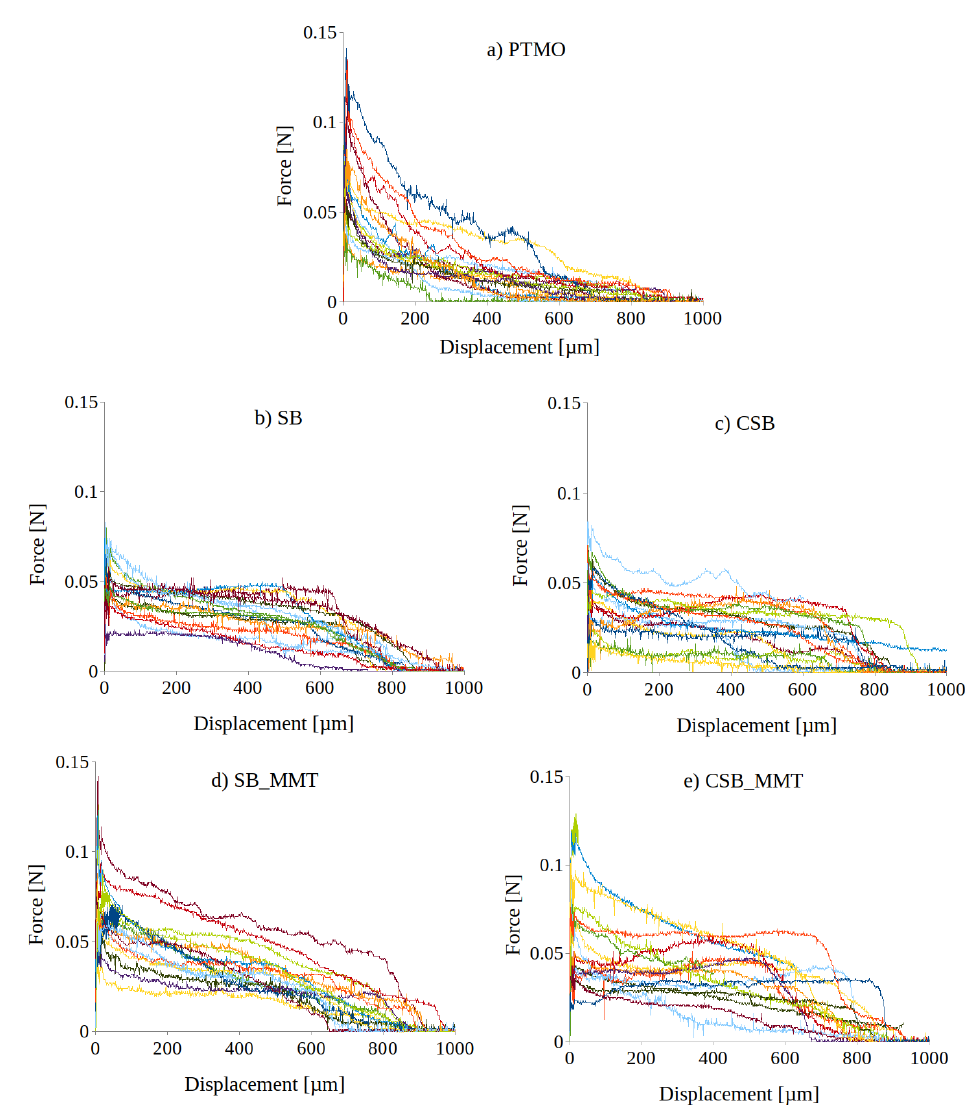
Figure 10. Force-displacement curves of single fiber pull-out tests, with the different colors of the curves relative to the individual samples